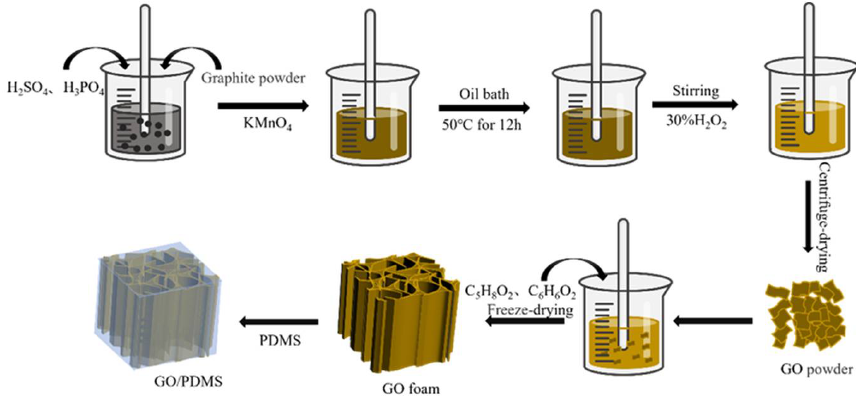
Figure 1. The fabrication process of 3D GO/PDMS composite.